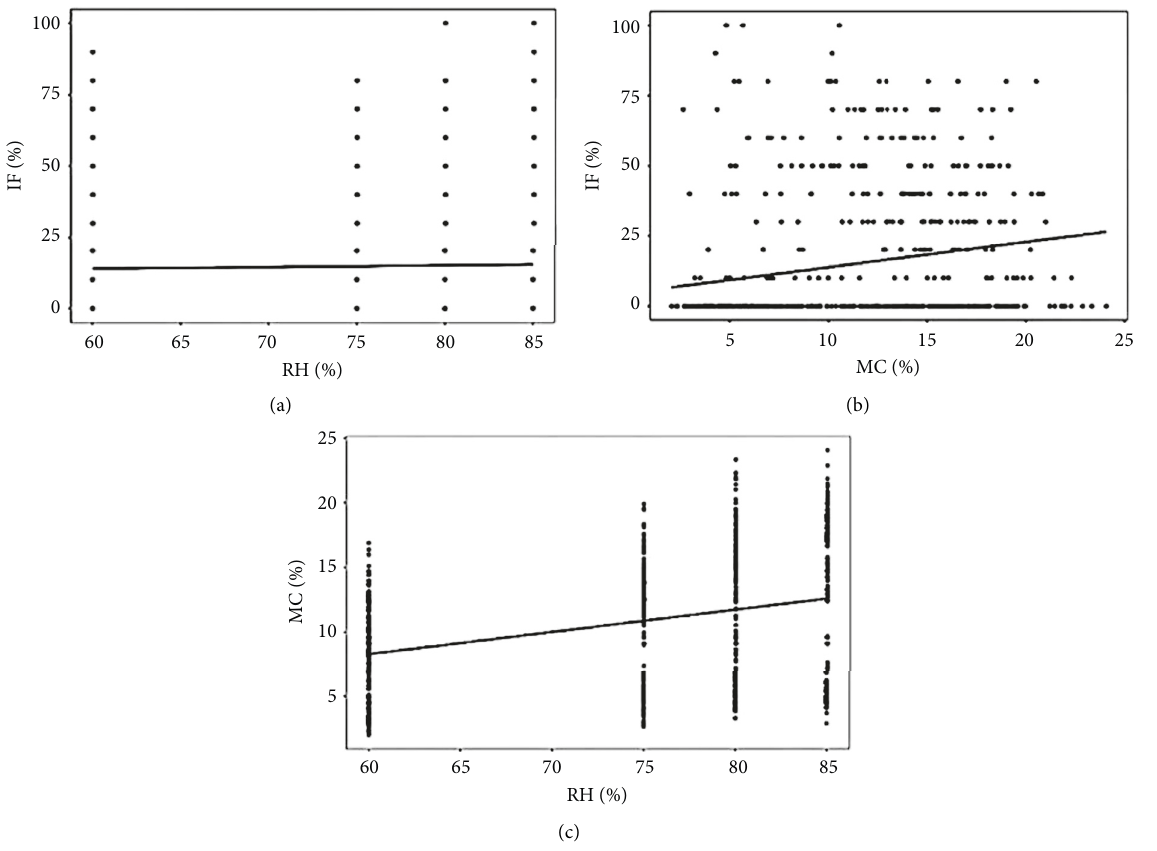
Figure 3: General correlations between variables under study. (a) Correlation of HI and RH; (b) correlation of HI and CH of the seeds; (c) correlation of CH of the seeds and RH.